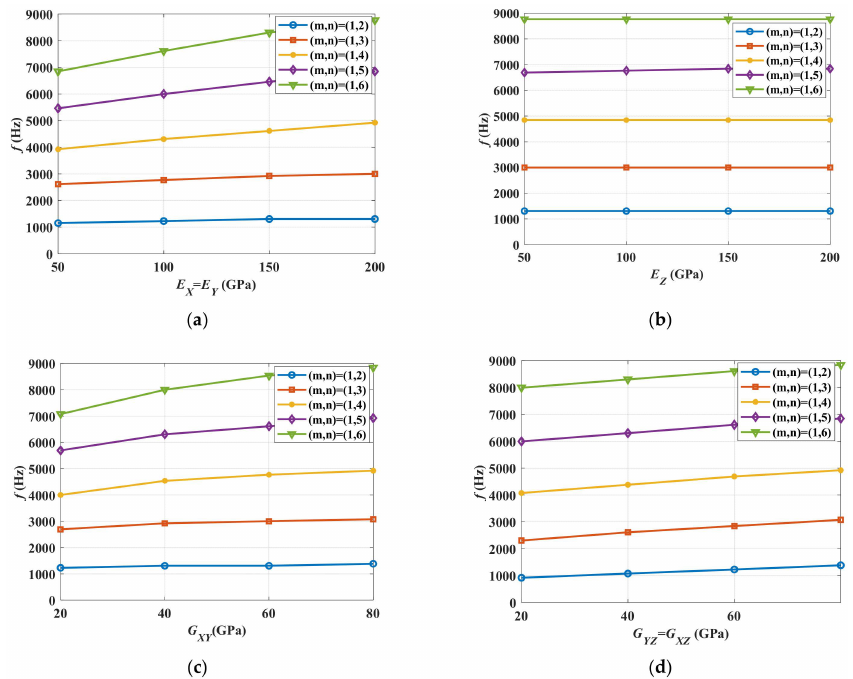
Figure 3. Anisotropic material property influence on stator core modal frequency of m = 1. ( a ) Effects of E X and E Y ; ( b ) Effects of E Z ; ( c ) Effects of G XY ; ( d ) Effects of G YZ and G XZ